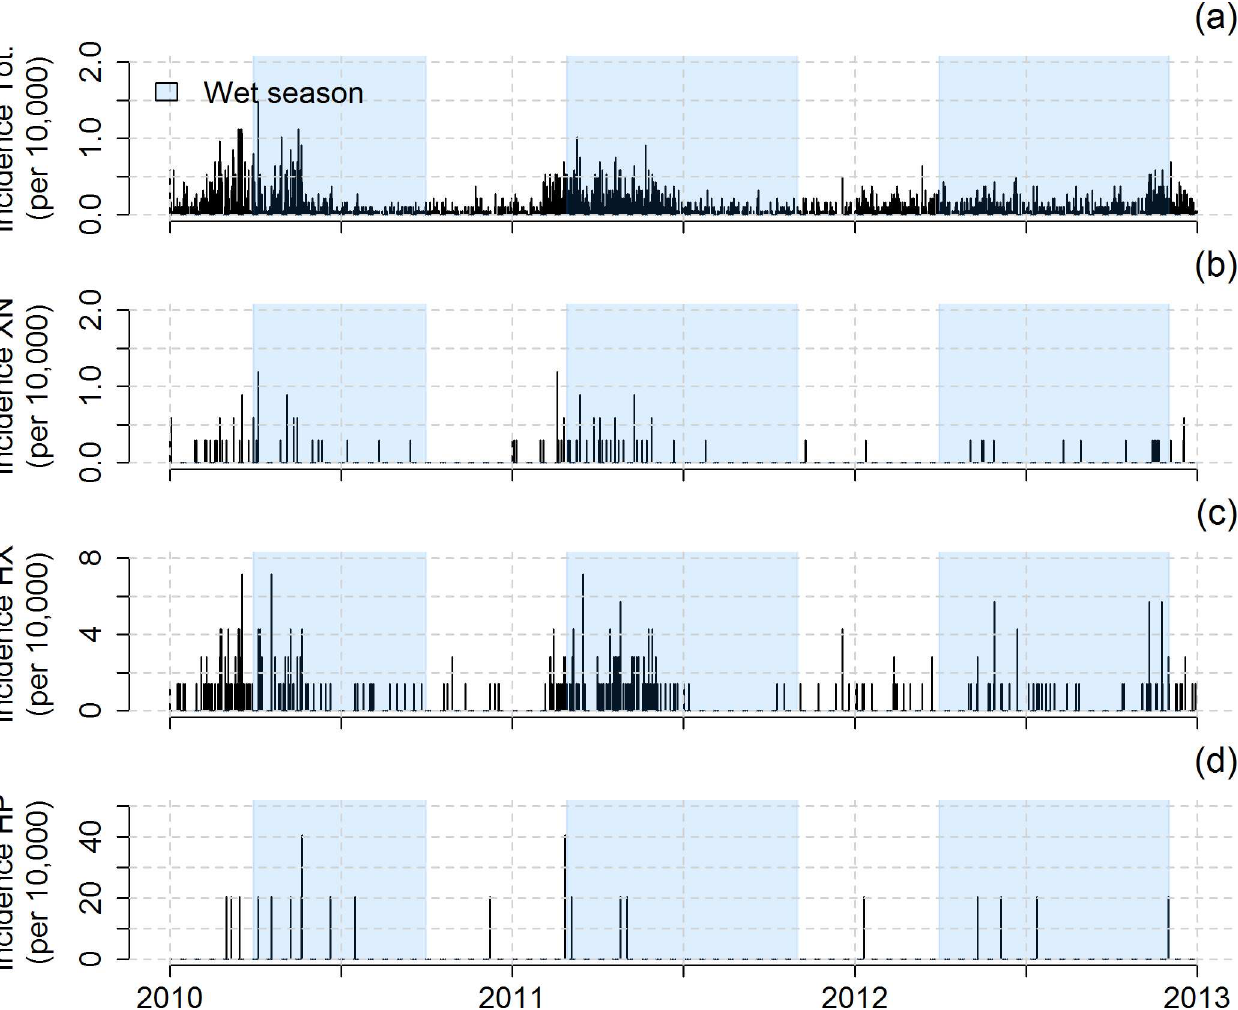
Fig 2. Daily total incidencerates (per 10,000inhabitants) recorded from 2010 to 2012 across (a) the 5 districts (Total) of interest in this study (LuangPrabang,Nan, Phonxai, Phoukhoune and Xieng Ngeun), (b) the Xieng Ngeun(XN) district includingthe NK20 samplingstation in the